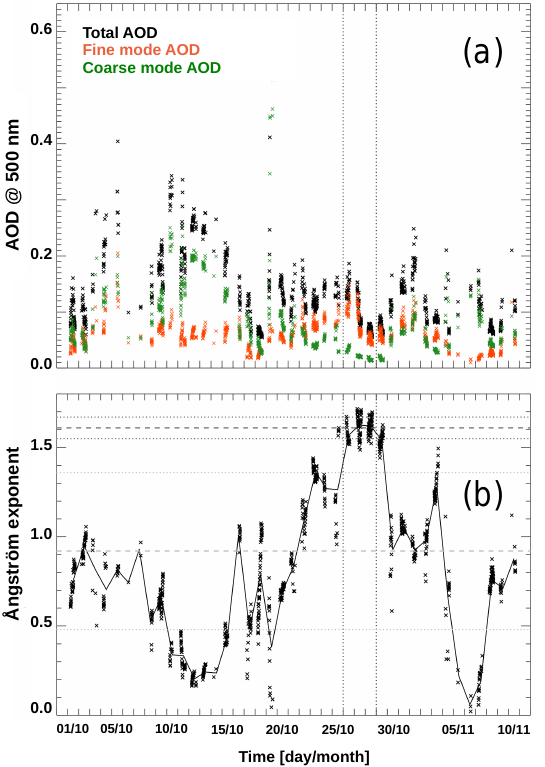
Figure 11. (a) Total (black crosses), fine mode (orange crosses) and coarse mode (green crosses) aerosol optical depth measure- ments; (b) Ångström exponent measurements (black crosses) and daily means (black line) at Lampedusa for the period 1 October to 10 November 2013. The vertical lines indicate the period 26– 29 October 2013. The average for the period 26–29 October (grey dashed horizontal line), ± 1 standard deviation (grey dotted hori- zontal lines), as well as the average for the whole month of Oc- tober 2013 (light grey dashed horizontal line), ± 1 standard devi- ation (light grey dotted horizontal lines), are also reported for the Ångström exponent.